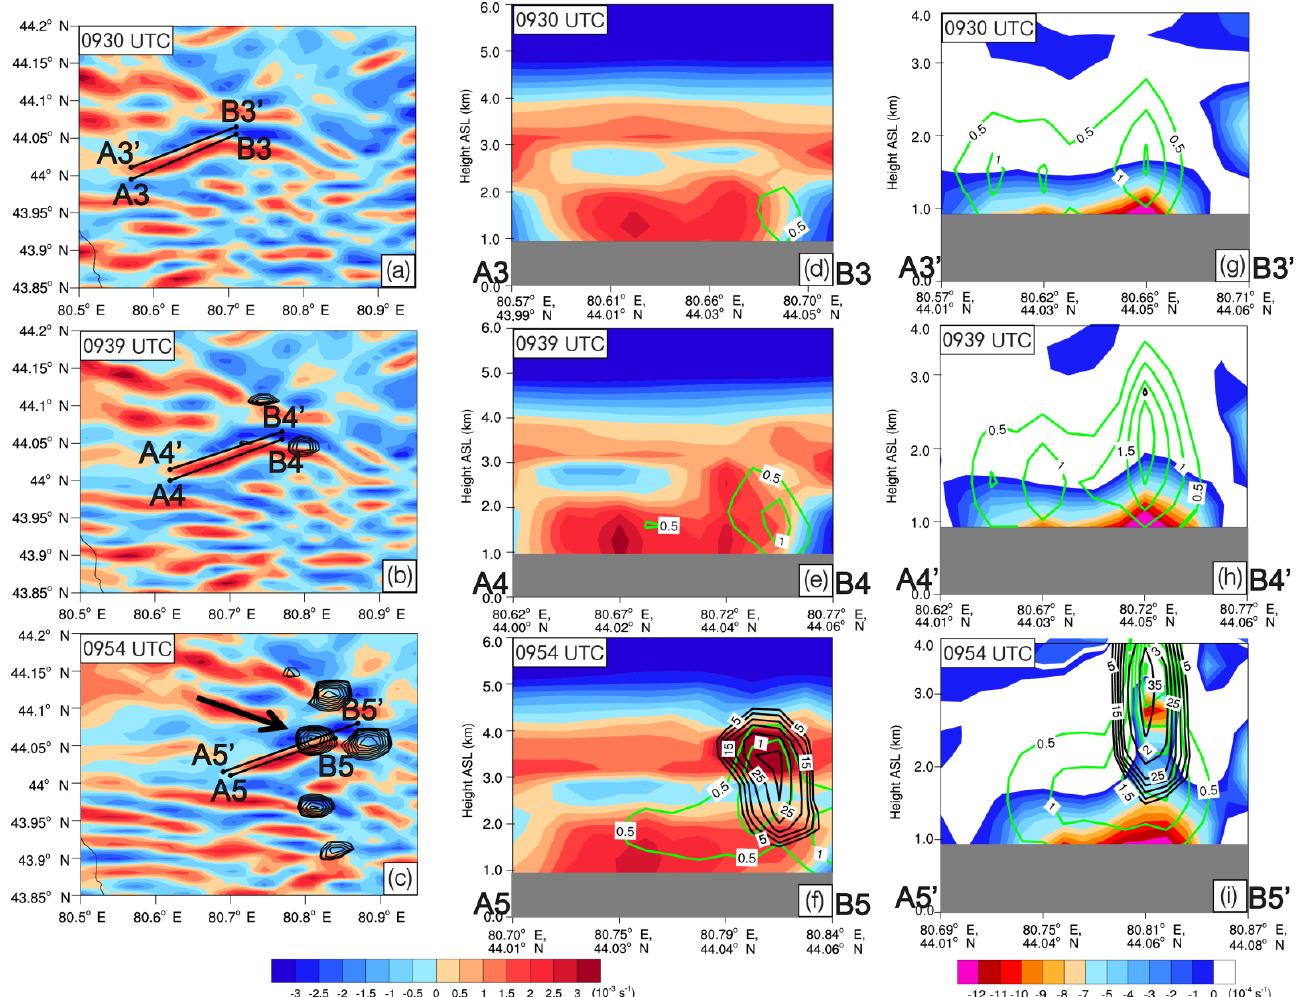
Figure 11. ( a – c ) Simulated horizontal vorticity on x-direction (abbreviated as HVx, shading, units: 10 −3 s −1 ) and composite reflectivity (thin black contours, unit: dBZ, with 5 dBZ intervals) at 1500 m (ASL) on 17 June 2016. ( d – f ) Vertical cross section of HVx (shading, units: 10 −3 s −1 ), vertical velocity (thick green lines, units: m s −1 , with 0.5 m s −1 intervals), and composite reflectivity (thin black lines, units: dBZ, with 5 dBZ intervals) along the line segments A3B3, A4B4 and A5B5 in ( a ), ( b ) and ( c ), respectively. ( g – i ) are the same as ( d – f ) but for the horizontal divergence (shading, units: 10 −4 s −1 ) along the line segments A 3′ B 3′ , A 4′ B 4′ and A 5′ B 5′ in ( a ), ( b ) and ( c ), respectively. The specific time is shown in the upper right corner of each panel, and the dark grey shading shows the area below ground.